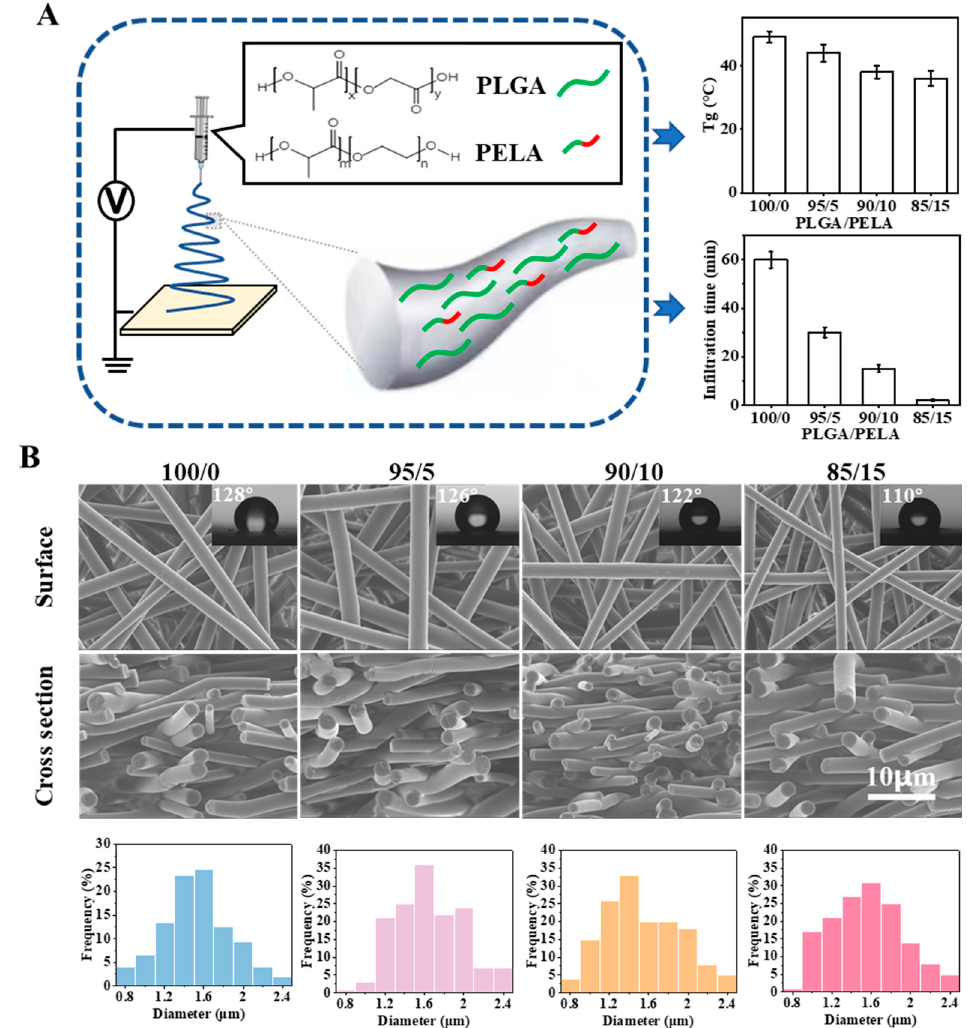
Figure 2. Preparation of fibrous membranes with the same physical structure and different chemical components. ( A ) Schematic illustration of blending PLGA with PELA; ( B ) SEM images, contact angle images, and diameter distributions of the electrospun membranes (i.e., 100/0, 95/5, 90/10, and 85/15). Here, 100/0, 95/5, 90/10, and 85/15 indicate the weight ratio of PLGA to PELA in the membranes.